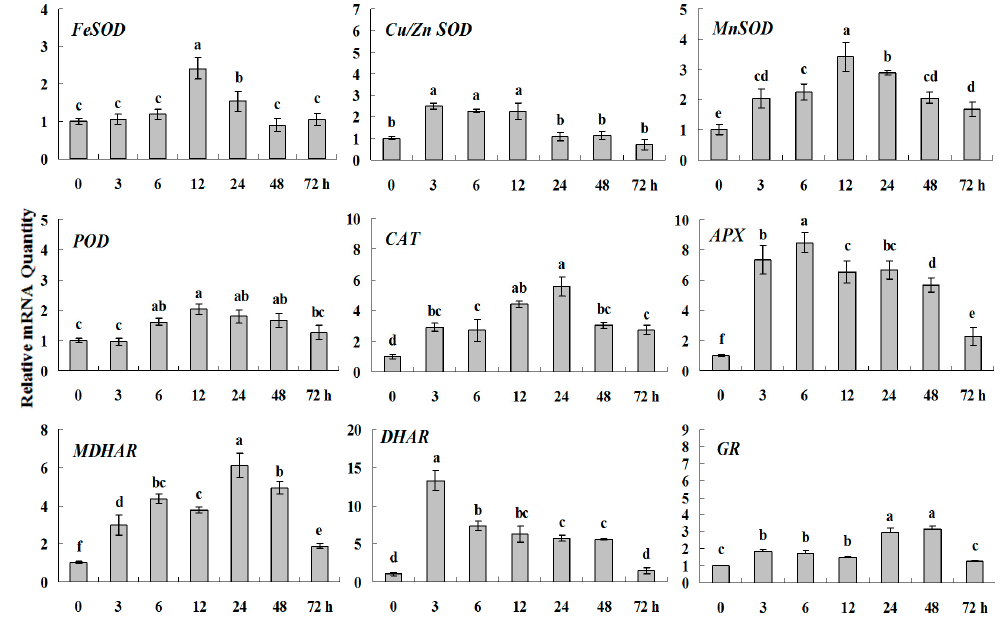
Figure 8. Quantitative real-time RT-PCR was used to analyze of ROS-scavenging enzyme genes expression treatment with Spd and normalized to β -actin . White clover leaves were sampled after 0, 3, 6, 12, 24, 48 and 72 h treatment. Data represent means of three replicates. Error bars representing standard errors and the different letters above the bars represent significant difference ( p < 0.05).